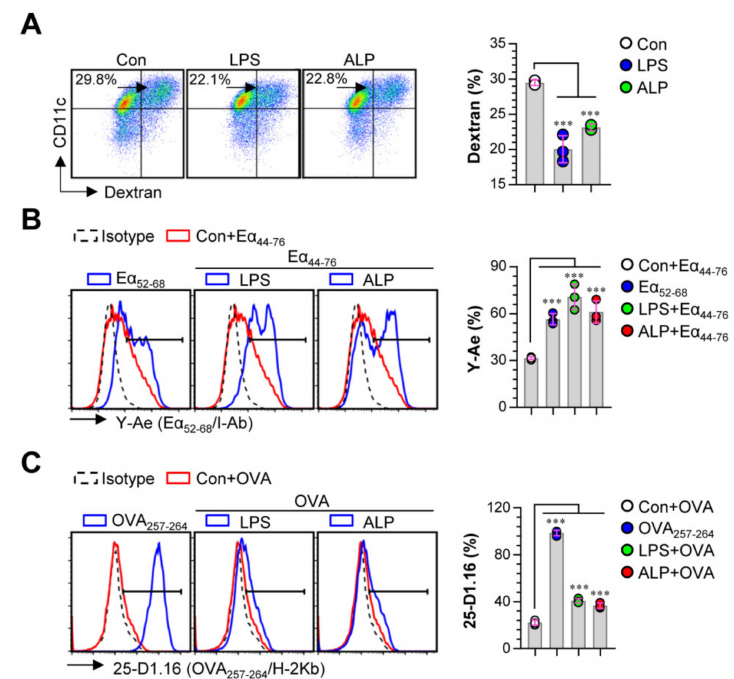
Figure 2. Antigen uptake and antigen-presenting ability of ALP-stimulated DCs. ( A ) Cells were stimulated with ALP (200 µ g / mL) or LPS (100 ng / mL) for 18 h and cultured with dextran at 37 ◦ C for 30 min. The cells were labeled with anti-CD11c Ab and subjected to FACS analysis to detect dextran uptake. ( B , C ) Non-, LPS-, and ALP-treated cells were then treated with E α peptide (aa 44–76; 25 µ g / mL) or ovalbumin (OVA) (500 µ g / mL) for 24 h. After incubating, each group of cells was labeled with anti-CD11c, anti-Y-Ae, or anti-25-D1.16 mAbs for 15 min. Positive controls for antigen presentation, E α 52–68 (5 µ g / mL) or OVA 257–264 (5 µ g / mL), were used. Histogram data and bar graphs show the expression of E α 52–68 / I-Ab ( B ) and OVA 257–264 / H-2Kb ( C ) in the gated CD11c + population. Bar graph data are shown as the mean ± SD ( n = 3 samples) of 3 representative experiments. *** p < 0.001. SD; standard